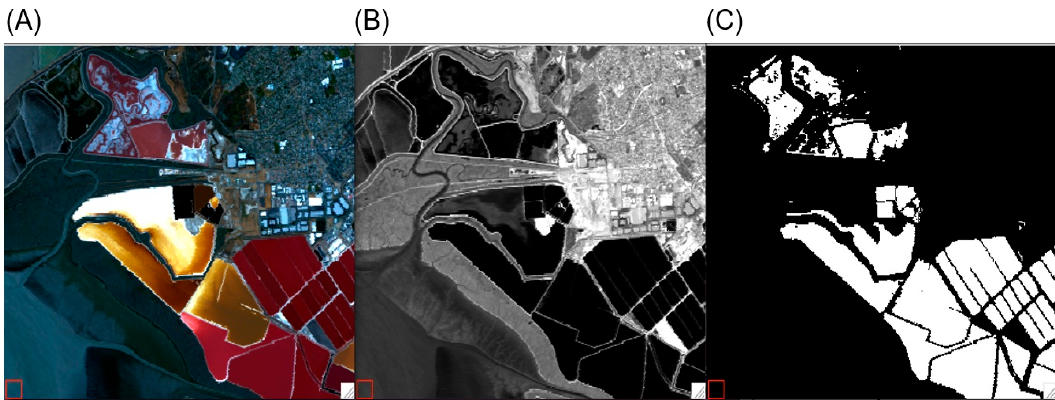
Figure 5. ( A ) A true color RGB image processed from an AVIRIS data set measured over salt evaporation ponds in the southern portion of the San Francisco Bay at UTC 2002 on 11 June 2008 when the red-colored algae were present; ( B ) the 2.25- µ m channel image over the same area; ( C ) the floating vegetation mask.